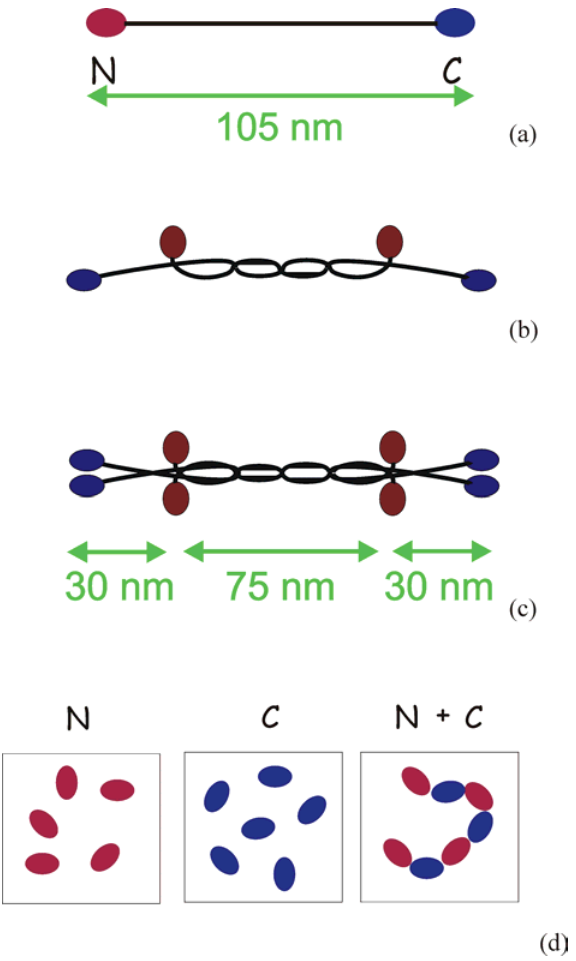
FIGURE 3. (a) Diagram of a collagen VI molecule. Collagen VI is a 105-nm-long molecule with massive globular domains at the extremities. Two molecules can interact laterally with a 30-nm axial shift to form dimers (b) . Intertwining of the monomers in the adjacent regions is seen. (c) Dimers join laterally to form tetramers. (d) Cleaved globular domains join linearly, N-terminals with C- terminals and vice versa, but homotypic N- or C-terminal associations are not